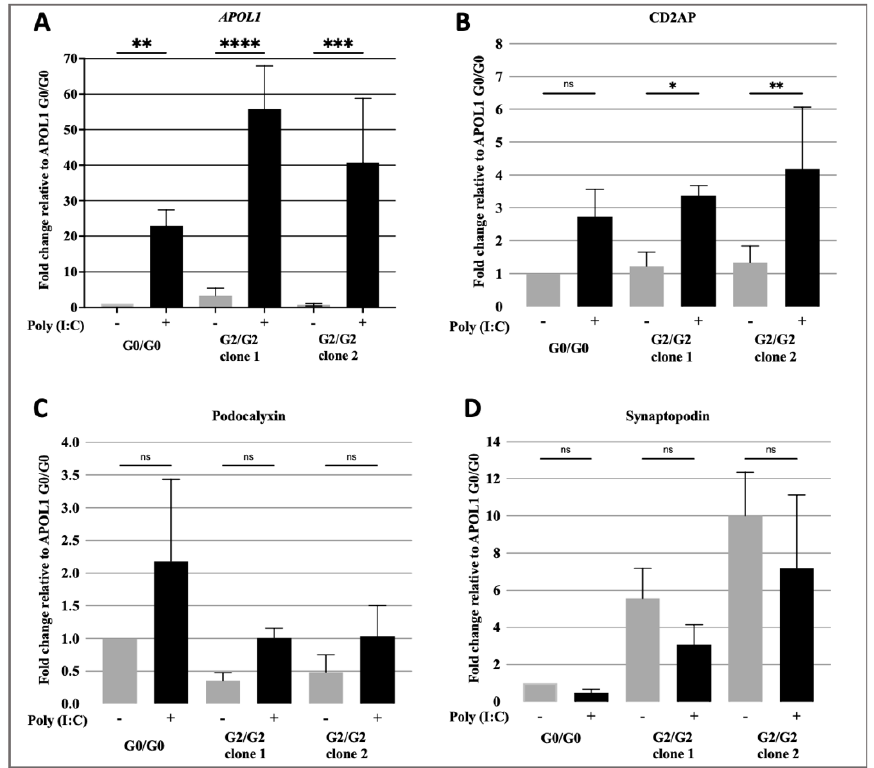
Figure 2. Changes in gene expression upon APOL1-induction. qPCR analysis of expression of the APOL1 ( A ) and podocyte-specific genes CD2-associated protein (CD2AP) ( B ); podocalyxin ( C ) and synaptopodin ( D ) in APOL1 G0/G0, APOL1 G2/G2 clones 1 and 2 following incubation with poly (I:C) for 24 h. Each bar represents the mean ± SD of three independent experiments, performed in technical triplicates. * p < 0.05; ** p < 0.01; *** p < 0.001; **** p < 0.0001.